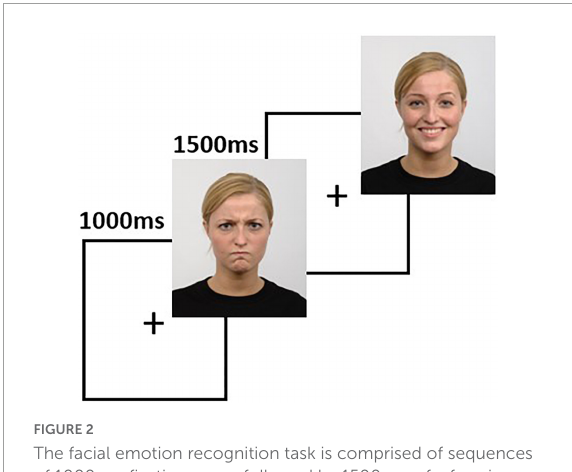
FIGURE2 The facial emotion recognition task is comprised of sequences of 1000 ms fixation cross, followed by 1500 ms of a face image. In this figure, we show two sample trials. Source for the images in this figure: Radboud Faces